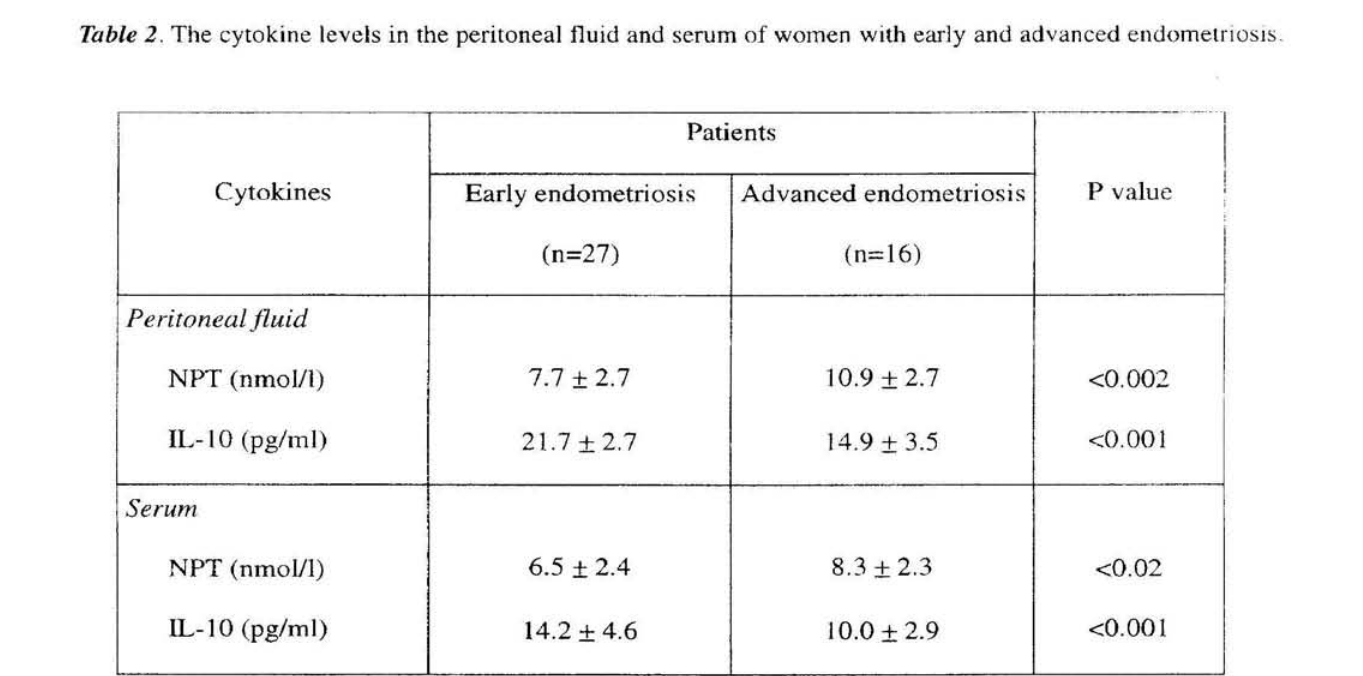
Table 2. The cytokine levels in the peritoneal fluid and serum of women with early and advanced endometriosis